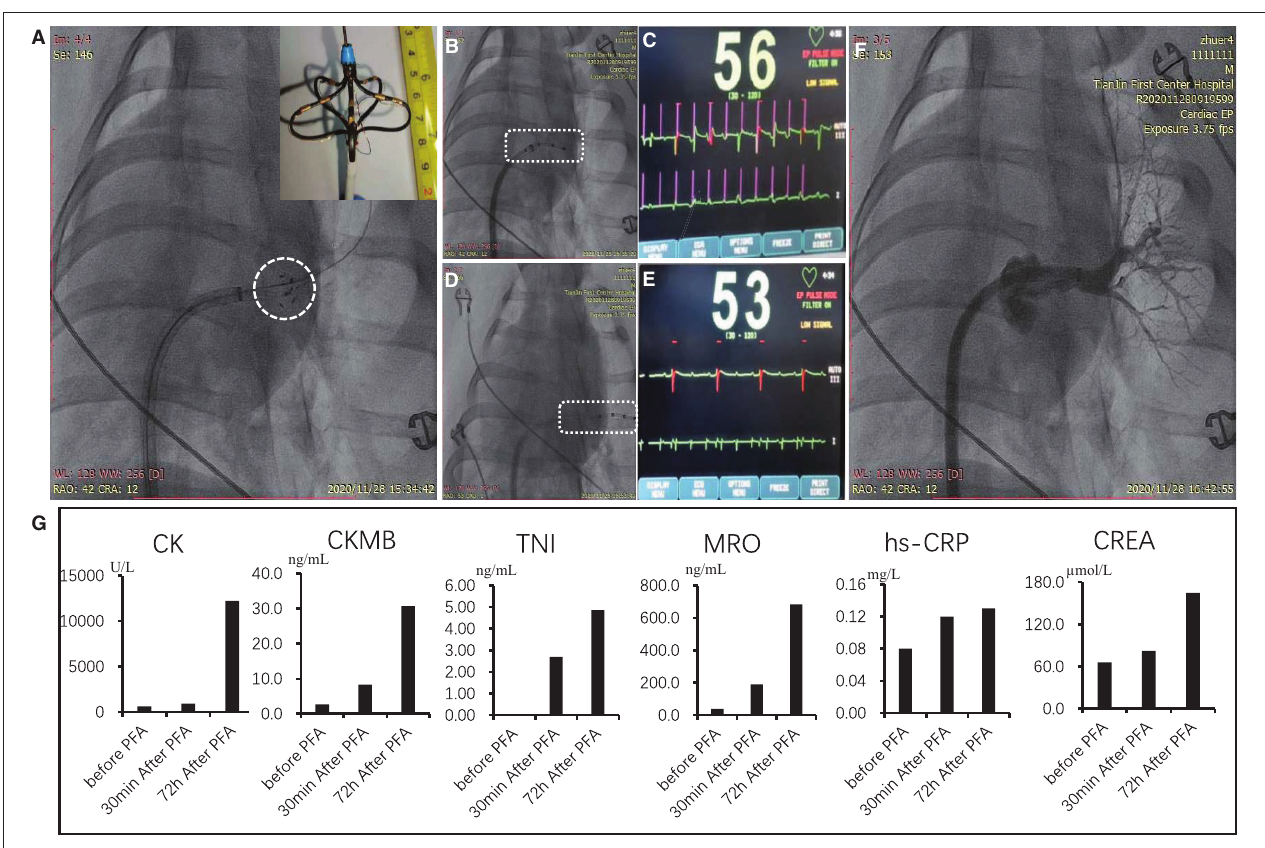
FIGURE 5 | PFA of the left superior pulmonary vein of Bama minipigs. (A) Position and shape of PFA electrodes; the embedding graph is the enlarged view of electrode tip. (B–E) Effect of PFA verified by cardiac pacing. (B) Pacing electrode was in the non-injured part of atrium. (C) ECG image after pacing; the first line is pacing signal; the second line is ECG signal. (D) Pacing electrode was in the pulmonary vein for PFA. (E) ECG image after pacing. (F) radiographic image of the ablated pulmonary vein after PFA. (G) Indexes of myocardial damage and inflammatory reaction before PFA, 30min and 72h after ablation. PFA, pulsed-field ablation.